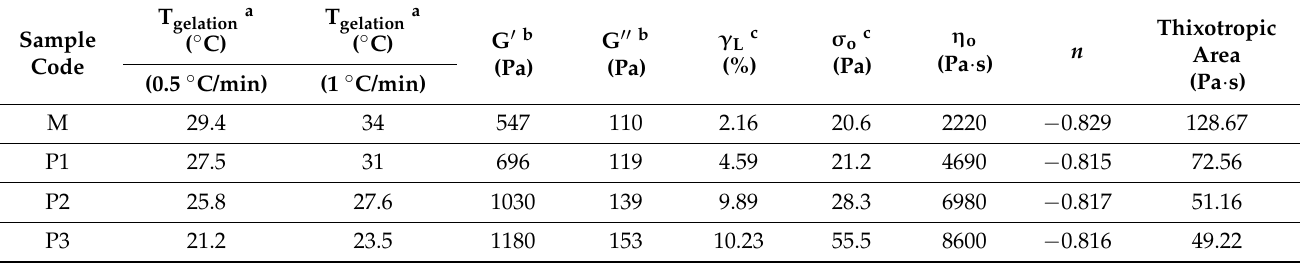
Table 2. Gelation temperature and some rheological characteristics of gel samples at 37 °C.